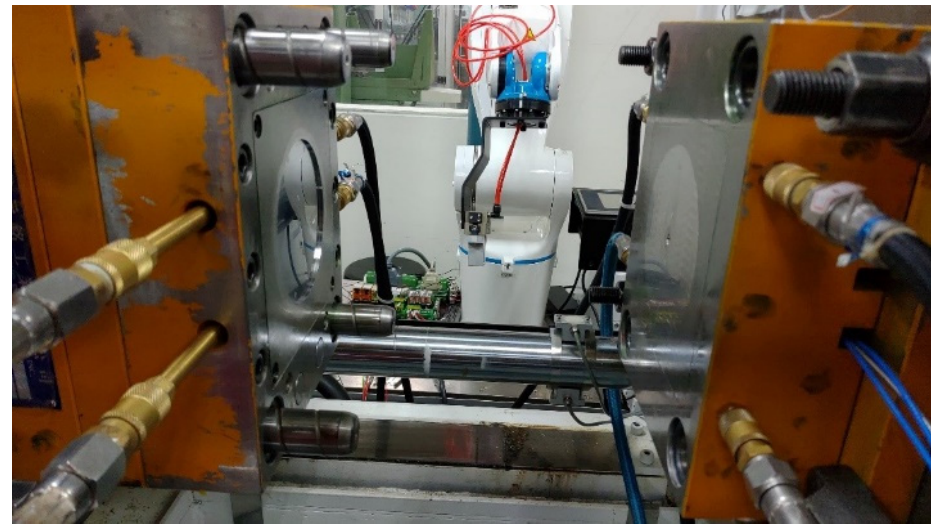
Figure 5. The mold of the thin plastic disk sample .